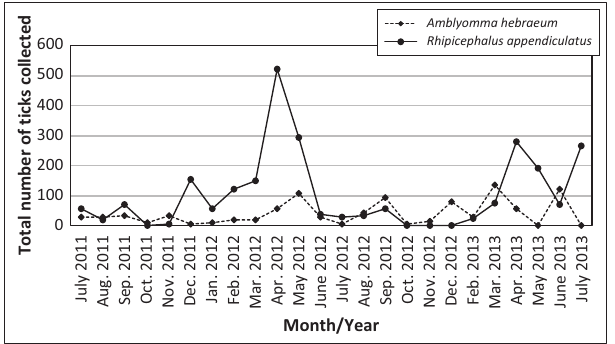
FIGURE 1: Total numbers of Amblyomma hebraeum and Rhipicephalus appendiculatus larvae collected between July 2011 and July 2013 by monthly drag-sampling of the vegetation on the farm Hoopdal KQ96.